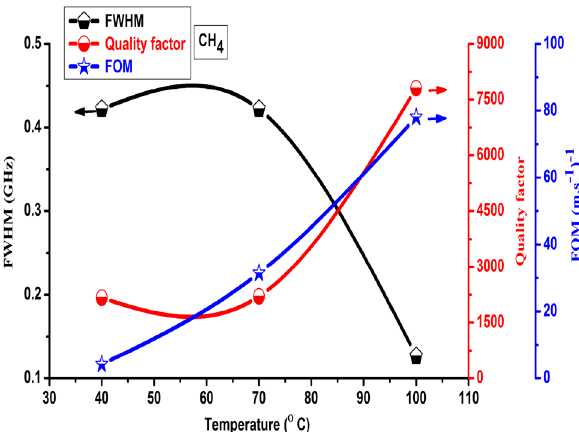
Figure 8. Effects of temperature on the quality factor and FOM of the FC(7, 1) quasi-periodic gas sensor towards CH 4 gas at 40, 70, and 100